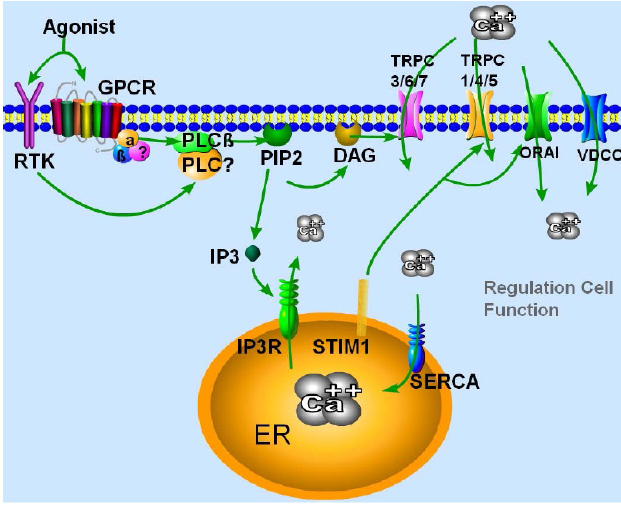
Figure 1. Activation and regulation of TRPC channels. Binding of an agonist to RTKs or GPCR, initiate a signaling cascade, causing PLC-mediated hydrolysis of phosphatidylinositol (4,5) bisphosphate (PIP diacylglycerol (DAG). DAG could directly activate certain TRPC channels. IP R, a ligand-gated ion channel, which leads to the release of Ca 2+ from the internal ER IP 3